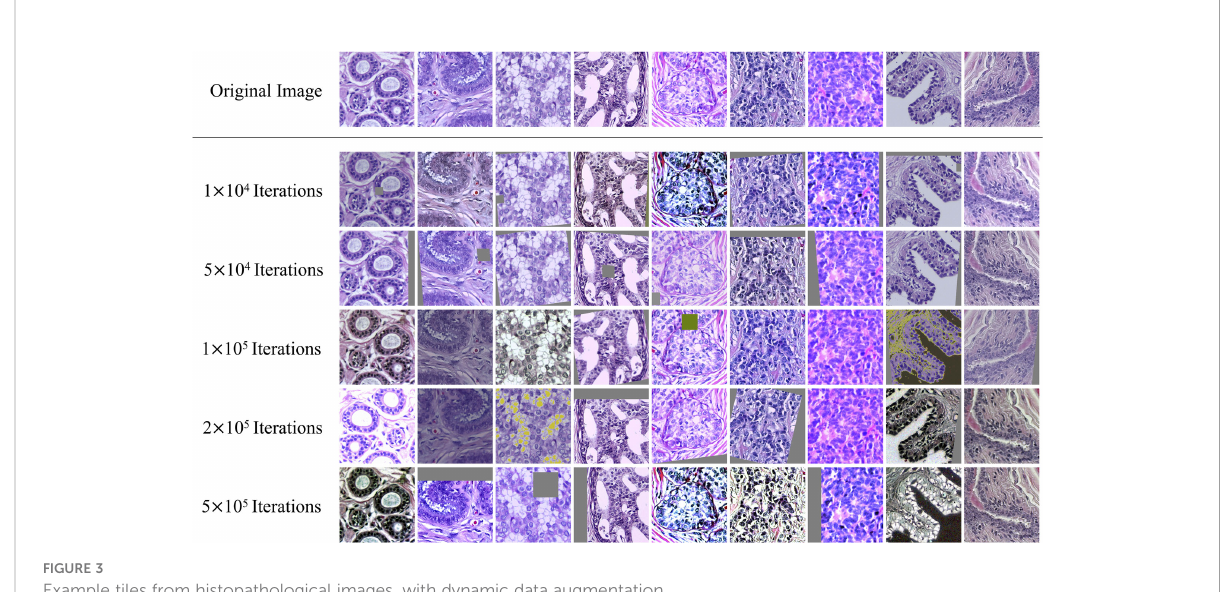
FIGURE 3 Example tiles from histopathological images, with dynamic data